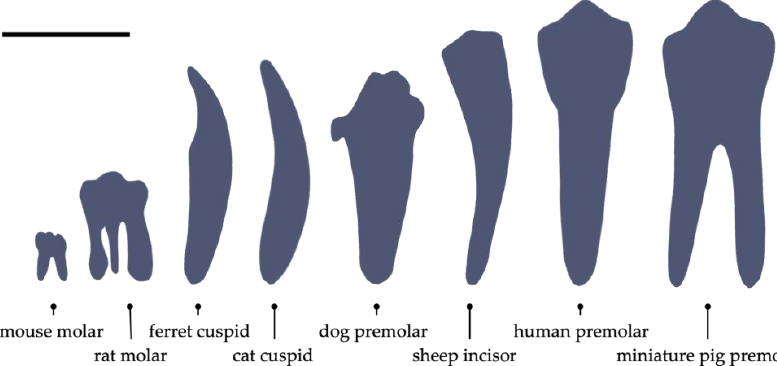
Figure 6. Relative tooth sizes of different species. Scale bar: 1 cm .